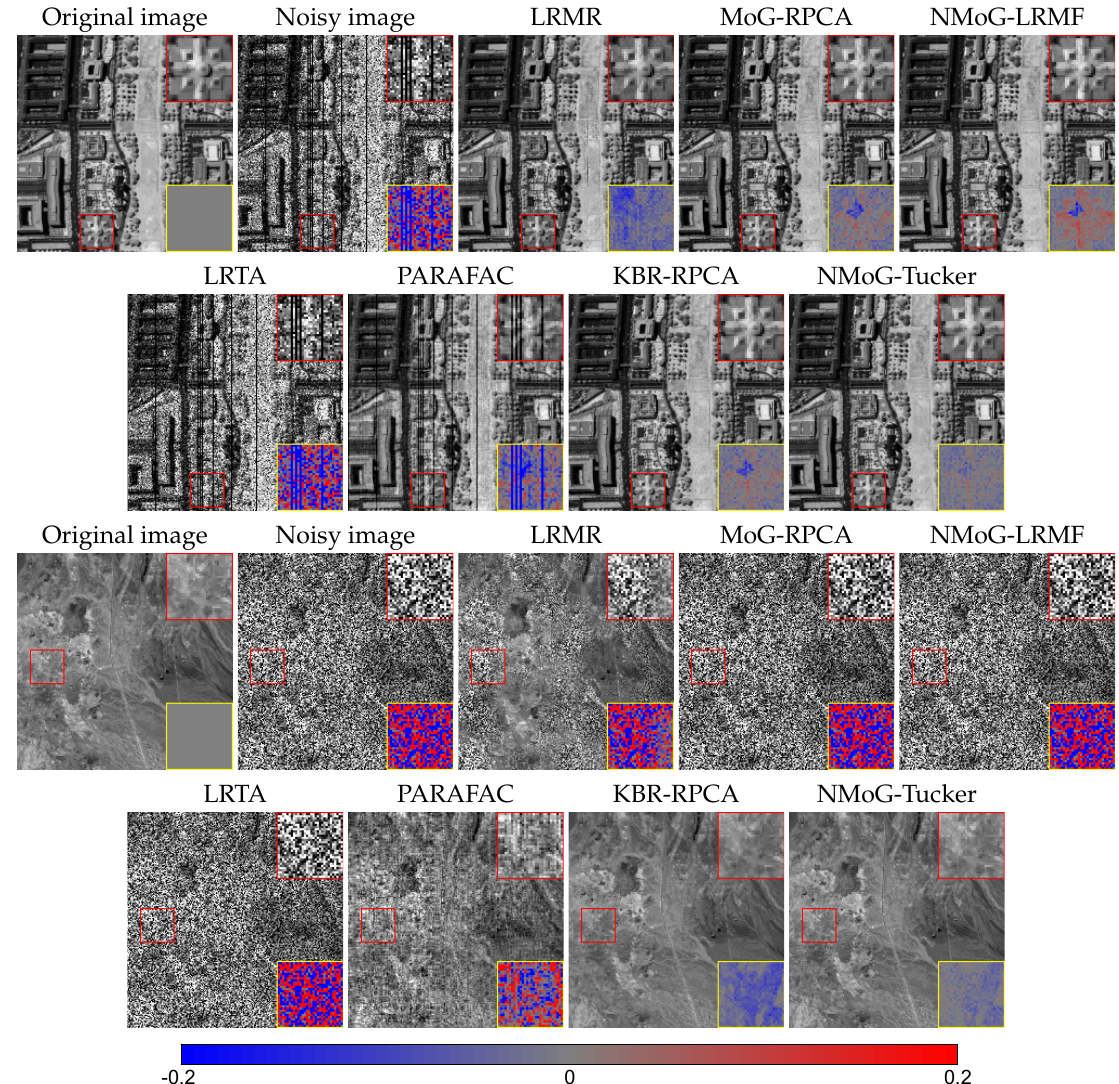
Figure 5. Simulated HSI denoising examples. Top two rows: band 58 in DCmall under mixture noise. Bottom two rows: band 43 in Cuprite under speckle noise. For better visualization, we show enlargements of two demarcated patches and the corresponding error maps, similarly to Figure